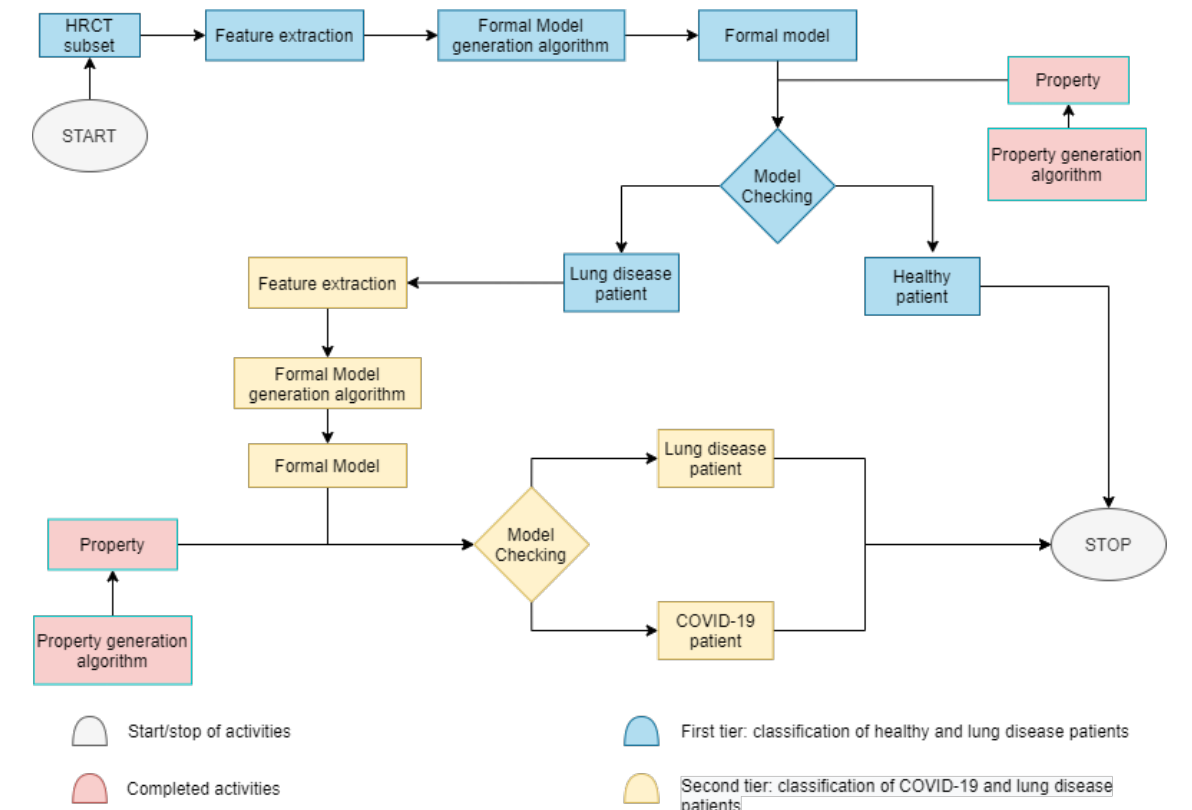
Figure 4. This block diagram describes the internal classification split. Grey boxes are the start and stop of activities. The pink boxes are the external activities. Property generation is already done during data collection. The blue boxes are first-tier activities, namely all activities aimed at classifying healthy or sick patients. The yellow represents the second tier, where the task is the classification between COVID-19 or non-COVID-19 patients.